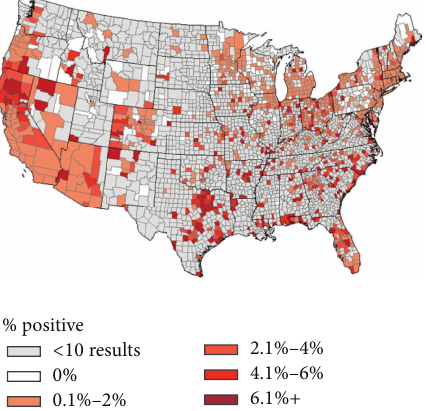
Figure 5: Courtesy of veterinary parasitology: US distribution of dogs testing positive for D. immitis antigen